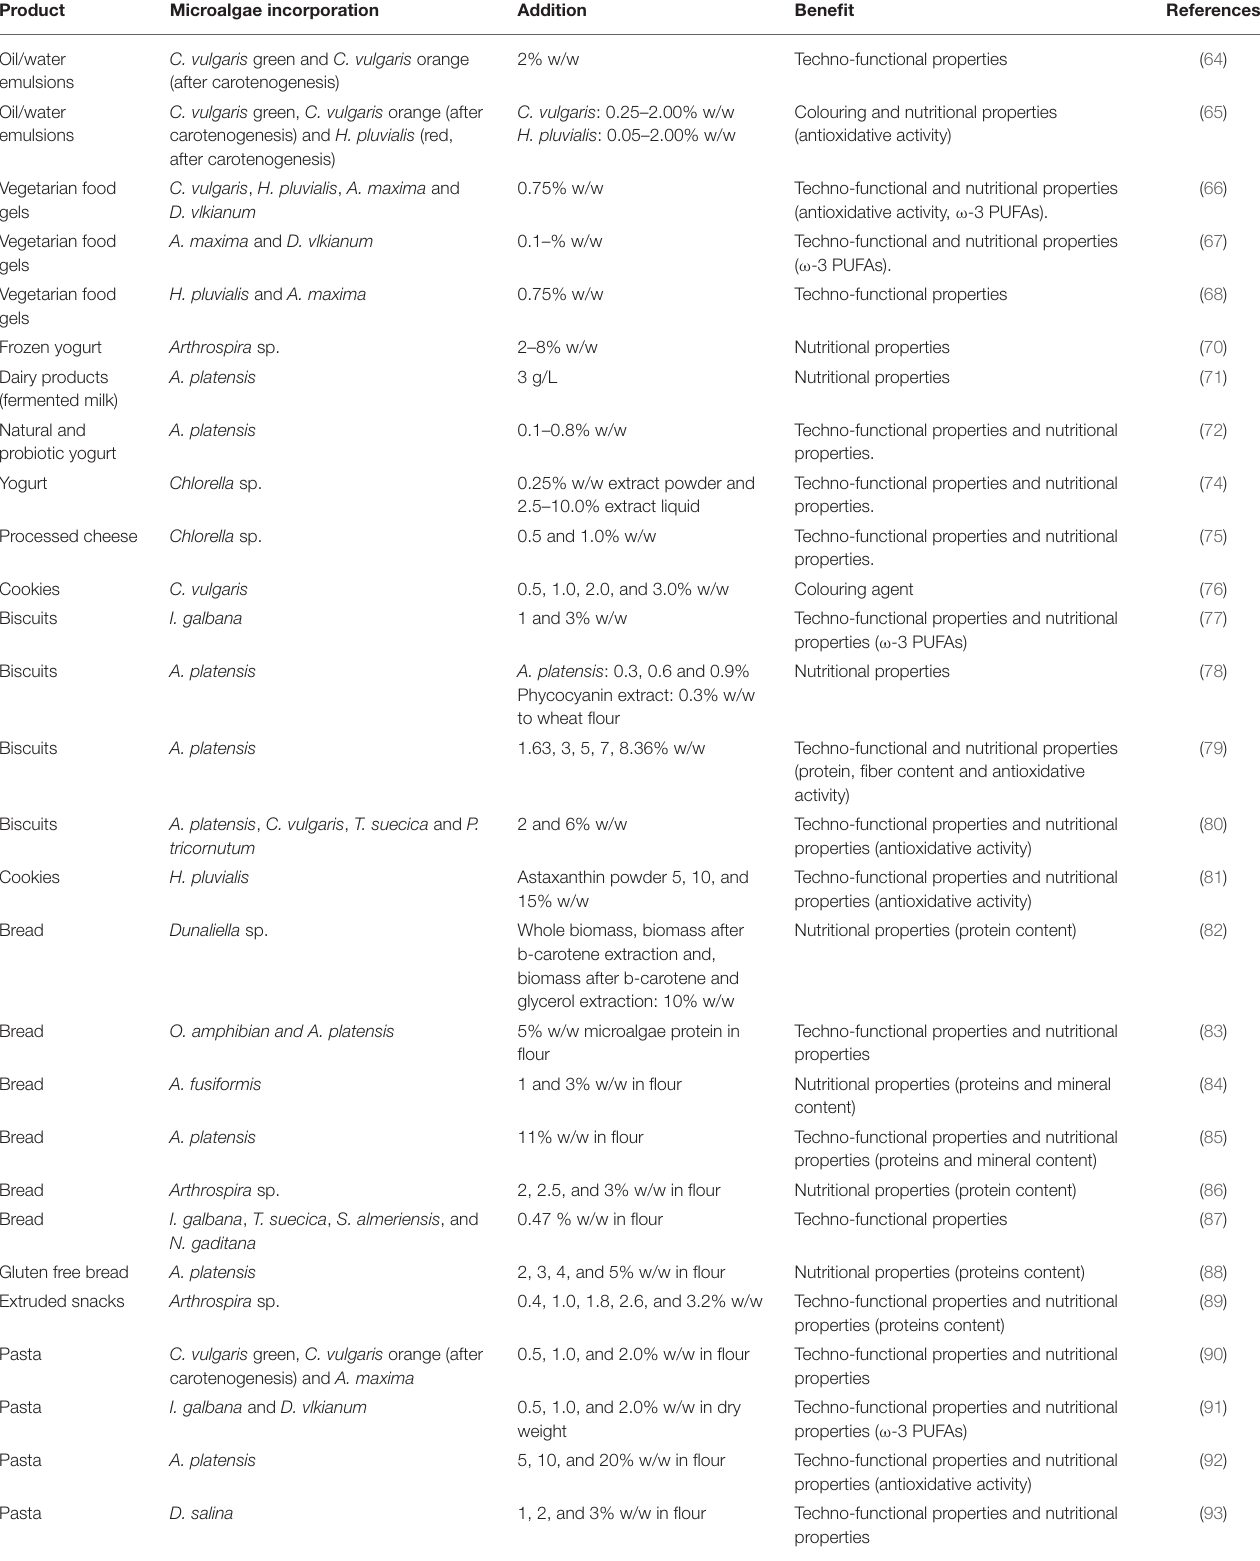
TABLE 1 | Microalgae incorporation in different food